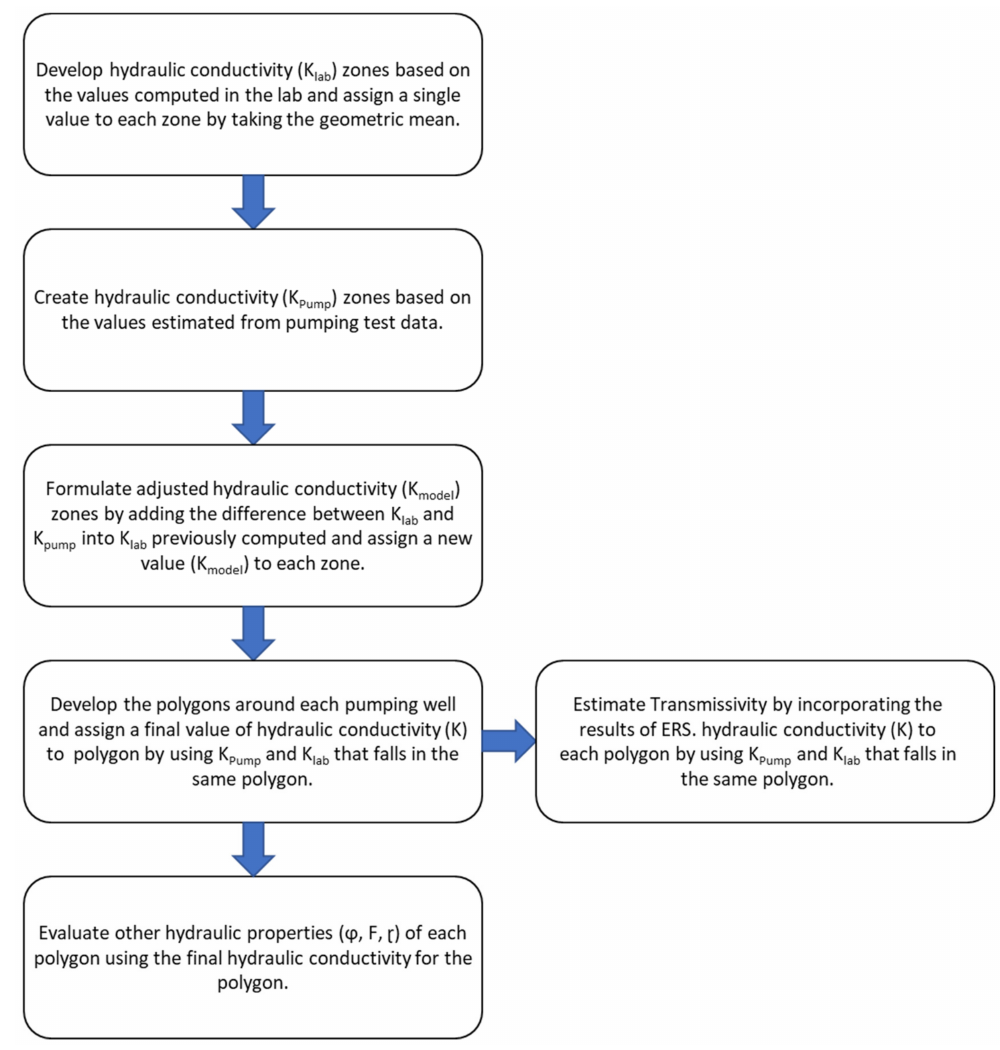
Figure 4. Workflow to establish the hydraulic conductivities zones and estimate the other hydraulic